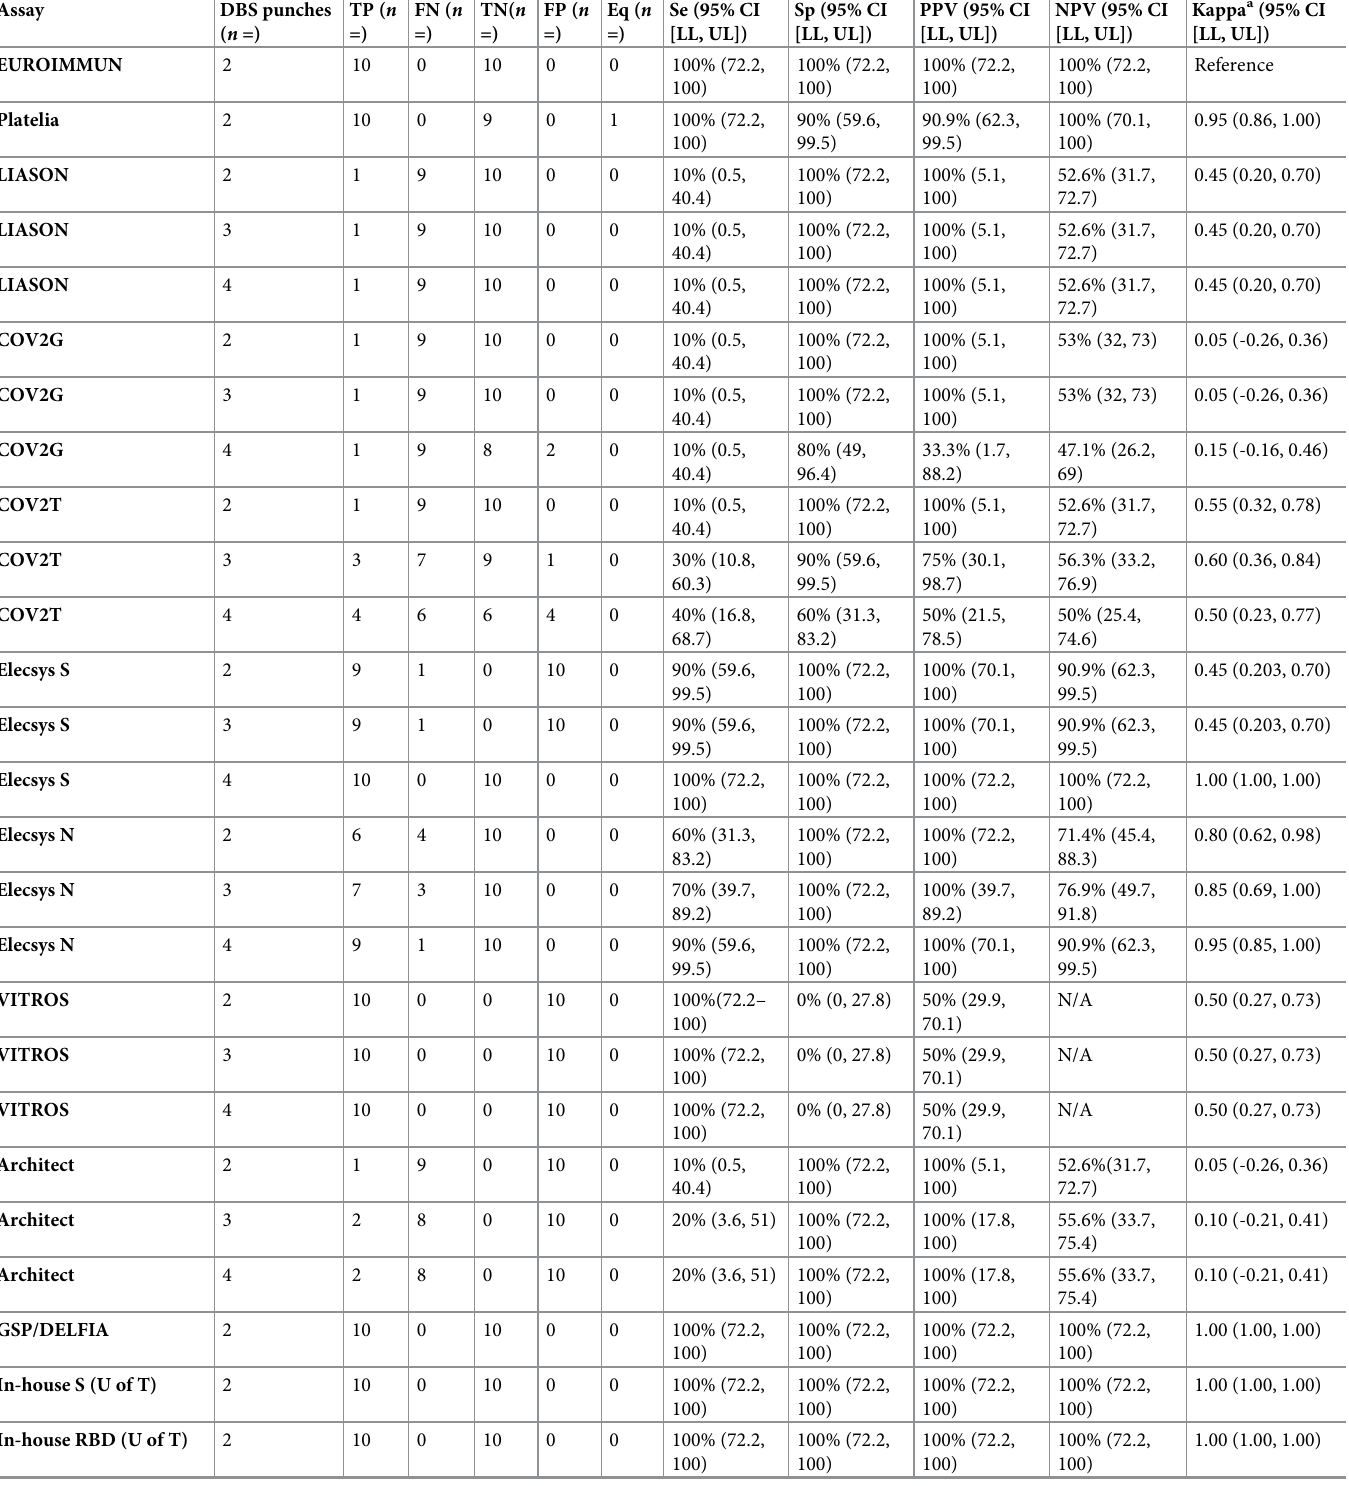
Table 1. Assay performance for SARS-CoV-2 antibody testing on dried blood spot specimens (DBS).